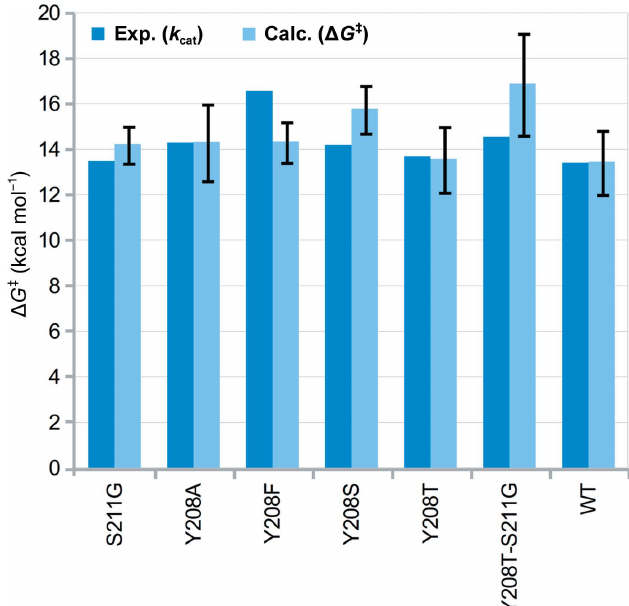
Figure 7 Experimental ( k cat ) and calculated activation free energies ( (cid:2) G ‡ ) for the deprotonation of DHAP by diverse S. cerevisiae TIM variants. Effects of amino-acid substitutions with experimental data from TIM enzymes of different organisms (chicken and Trypanosoma brucei brucei ) were also calculated for the yeast enzyme but, as expected, gave less agreement (see Supplementary Fig. S3), illustrating that mutational effects cannot be easily transferred between enzymes with only around 50% sequence identity. Note also that substitutions in the chicken enzyme shown in Supplementary Fig. S3 involve His95, which is catalytically relevant in the subsequent reaction step. The experimental k cat values were obtained at 25 (cid:8) C (Zhai et al. , 2015) and were used to estimate the (cid:2) G ‡ of the rate- limiting step. The corresponding data can be found in Supplementary Table S2.